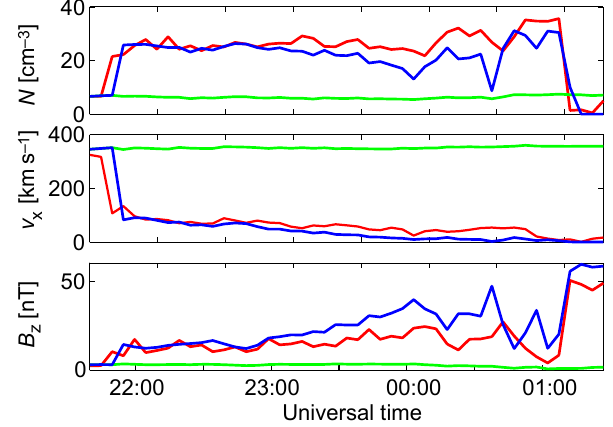
Figure 1. Magnetosheath spacecraft data on 31 August 2008 (red) and adjusted model results (blue) which determined the dipole mo- ment to M using the time-dependent OMNI solar wind data (green) presented in model coordinates.